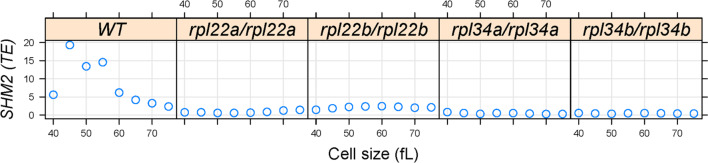
The translational efficiency of SHM2 is cell cycle-regulated.Cell size (in fL, x-axis) and the translational efficiency (TE) of SHM2, shown as Log2(expressed ratios) across the cell size series (y-axis), in the indicated strains. The values shown are the average from the three independent pools, for each 5 fL interval across.